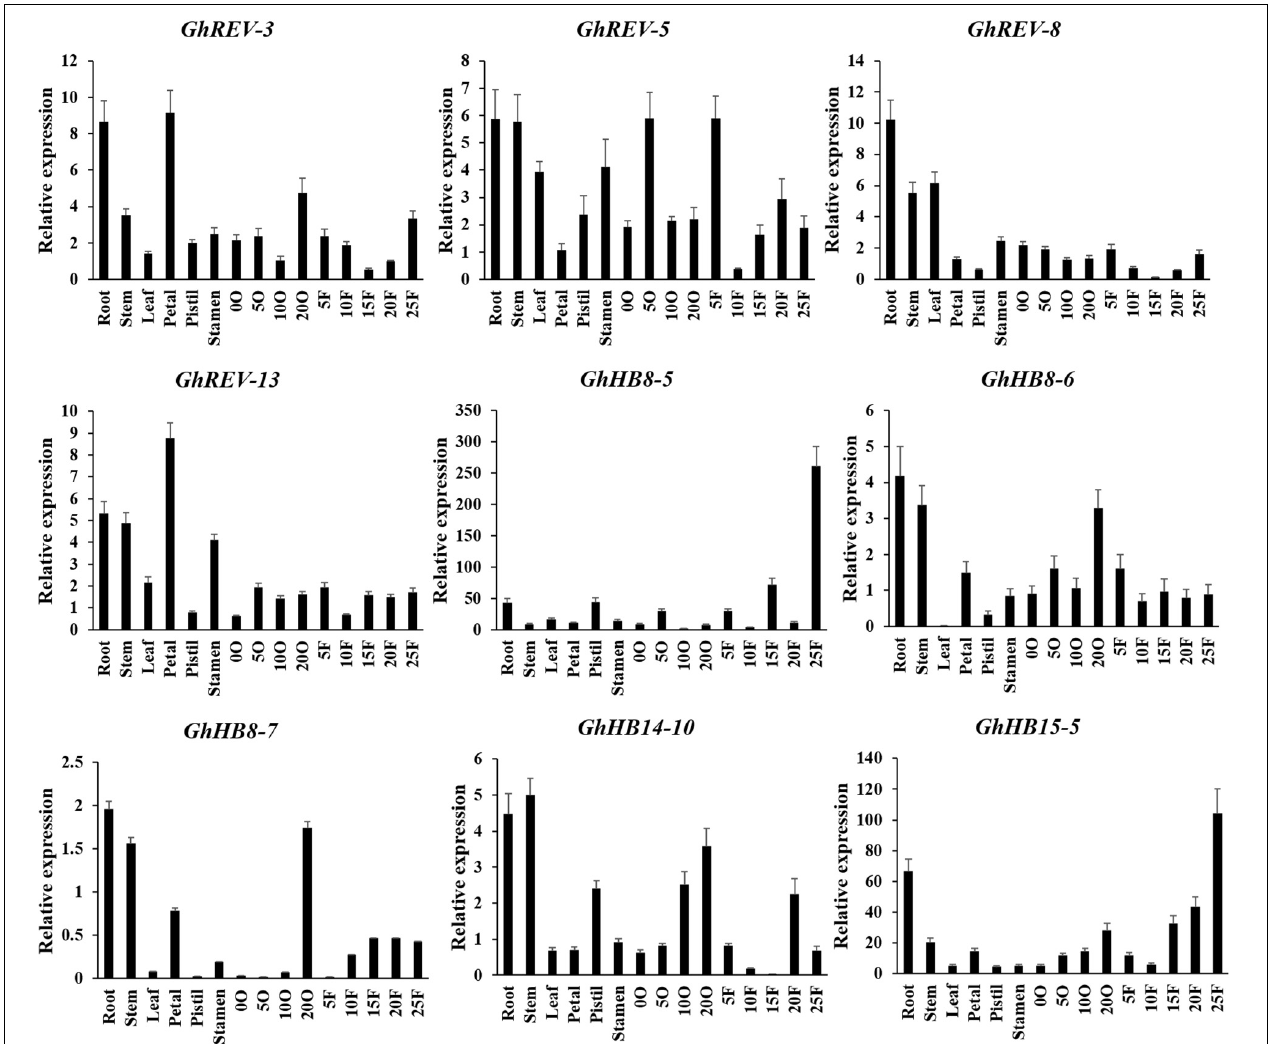
FIGURE 5 | Expression profiles of cotton HD-ZIP III genes in different cotton tissues. GhUBI1 was used as the internal control for normalization. Values represent the mean ± SD of three biological replicates. 0O, ovule in anthesis; 5O, ovules in 5 days post anthesis (DPA); 10O, ovules in 10 DPA; 20O, ovules in 20 DPA; 5F, fibers in 5 DPA; 10F, fibers in 10 DPA; 15F, fibers in 15 DPA; 20F, fibers in 20 DPA; 25F, fibers in 25